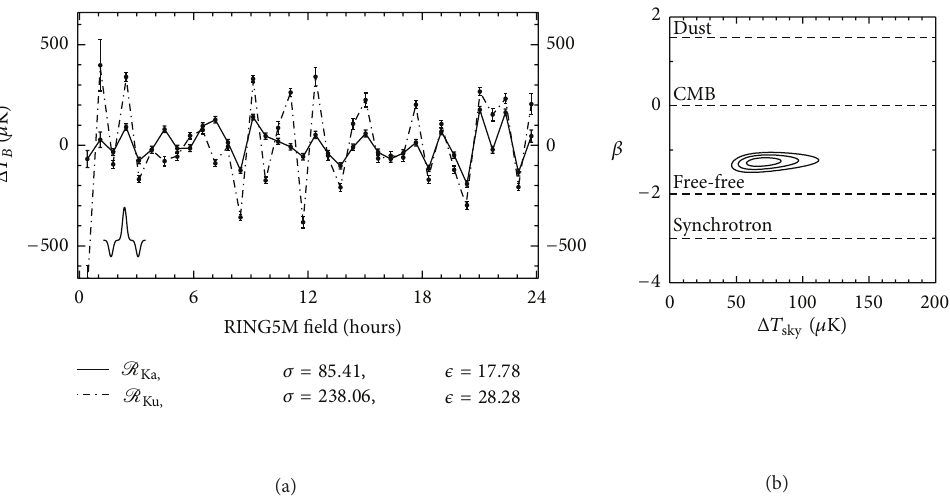
Figure 2: (a) Source-subtracted Ka (30GHz) and Ku-band (14.5GHz) data plotted to equal brightness temperature scale. Both represent sky amplitudes, convolved with the double-switched beam pattern of the RING5M observations, indicated at the bottom left of the figure. Approximately half of the RING5M fields show CMB-like signals (equal brightness temperature at both frequencies), while the other half show temperature signals with a steep spectral dependence. (b) The likelihood of the spectral index of the RING5M data, assuming that a single process is responsible for the signals at both frequencies. Clearly pure CMB ( 𝛽 = 0 ) is ruled out with high